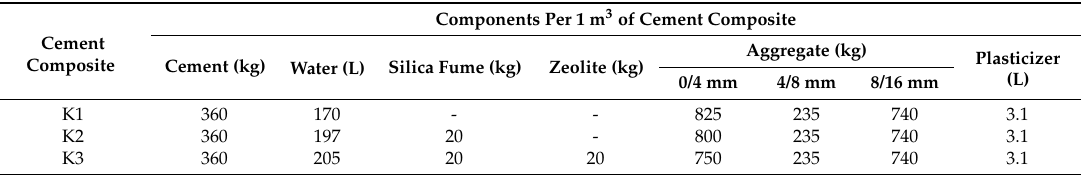
Table 1. Cement composite mixtures—composition per 1 m 3 of fresh concrete.